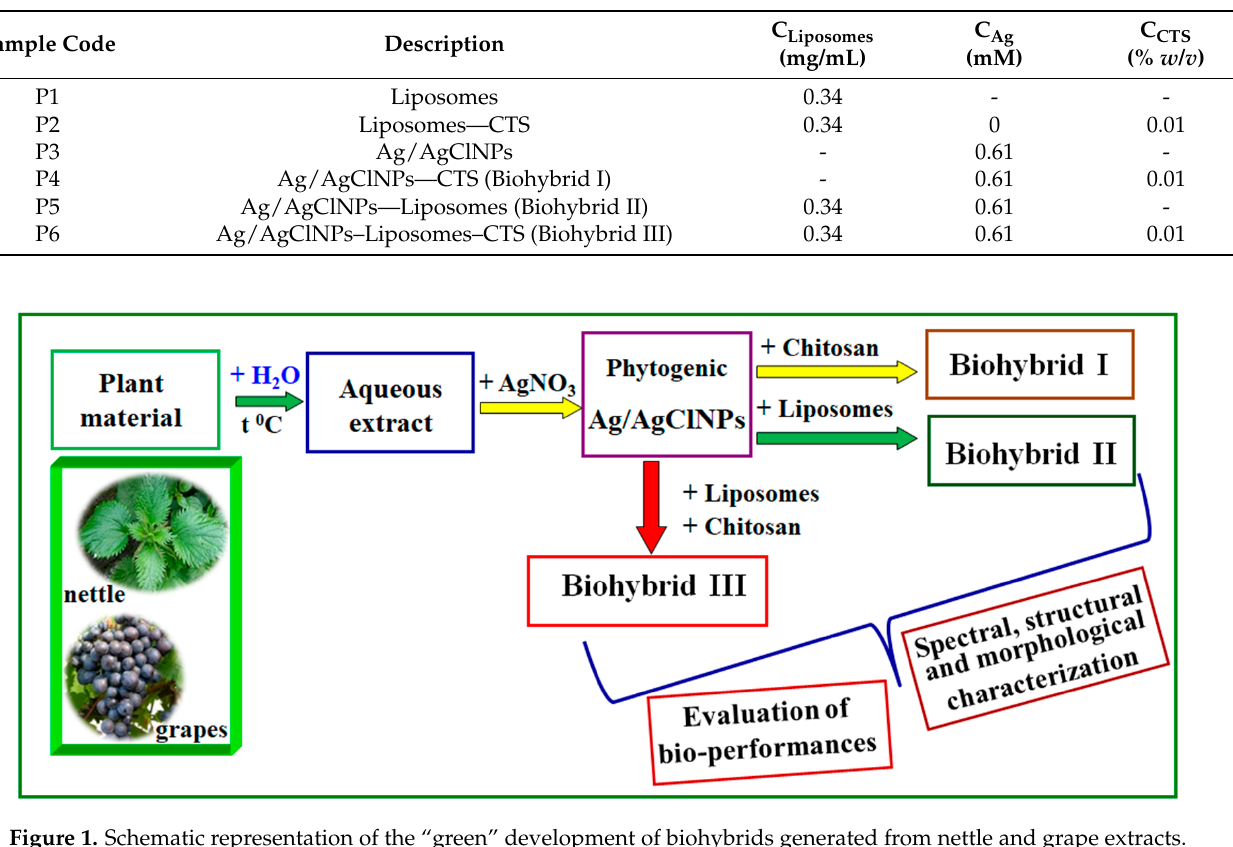
Table 1. Codes and descriptions of the samples.